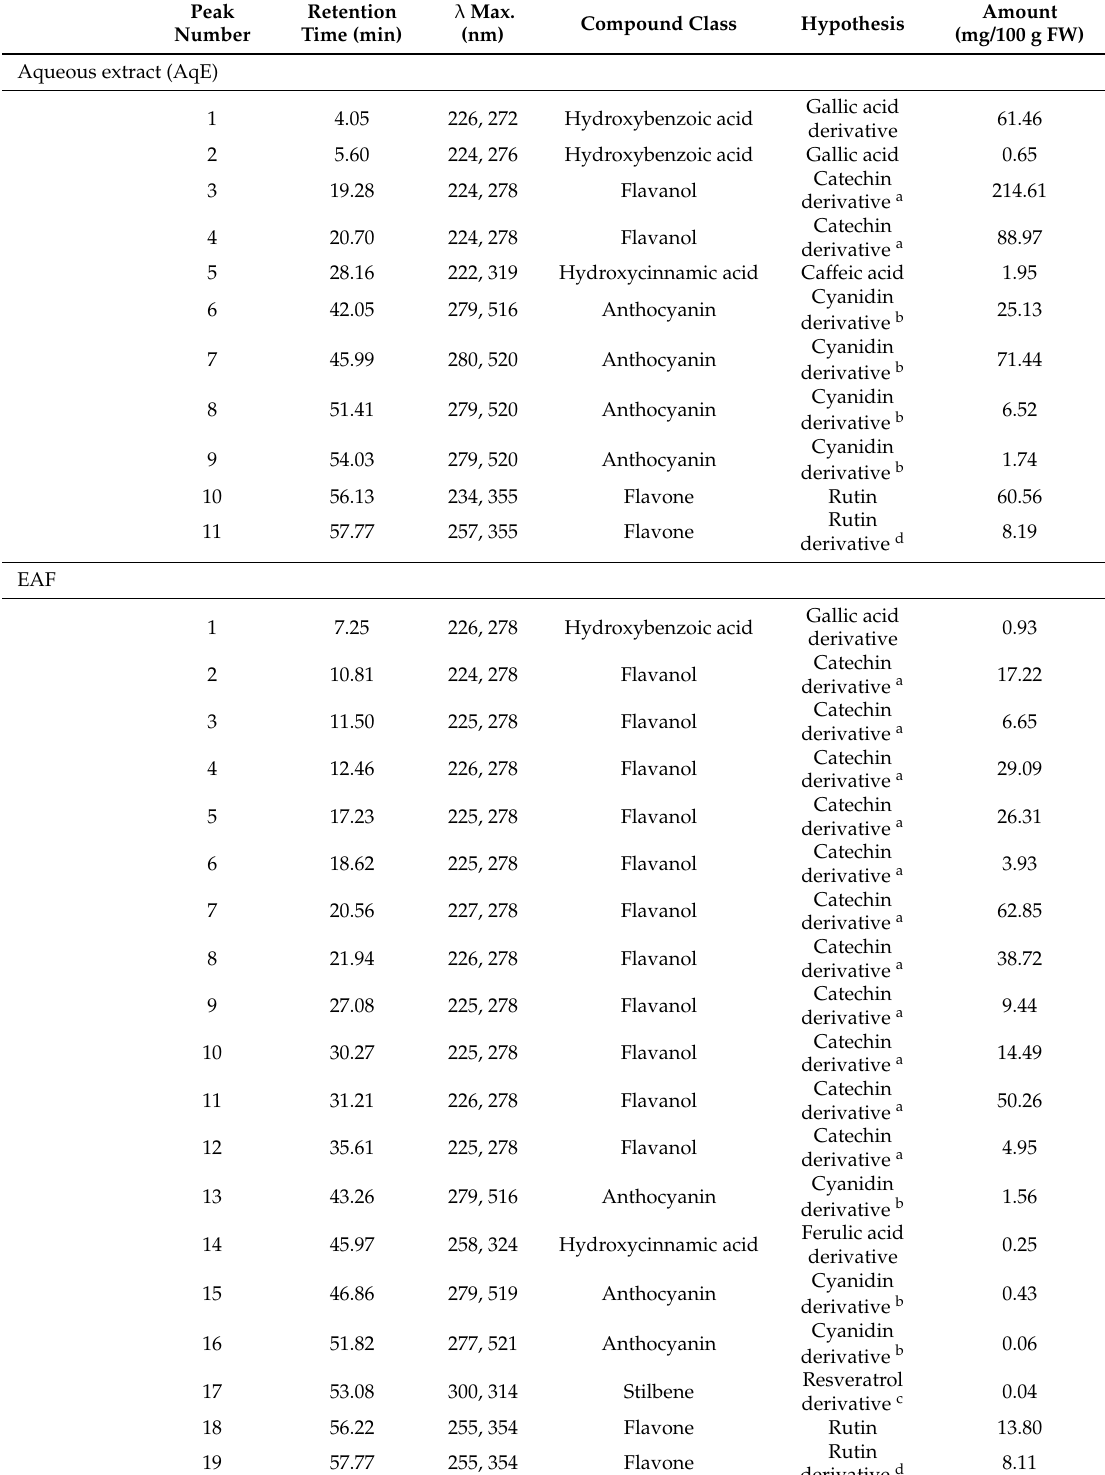
Table 3. Main classes of phenolic compounds identified and quantified in different extracts of tucum-do-cerrado peel by